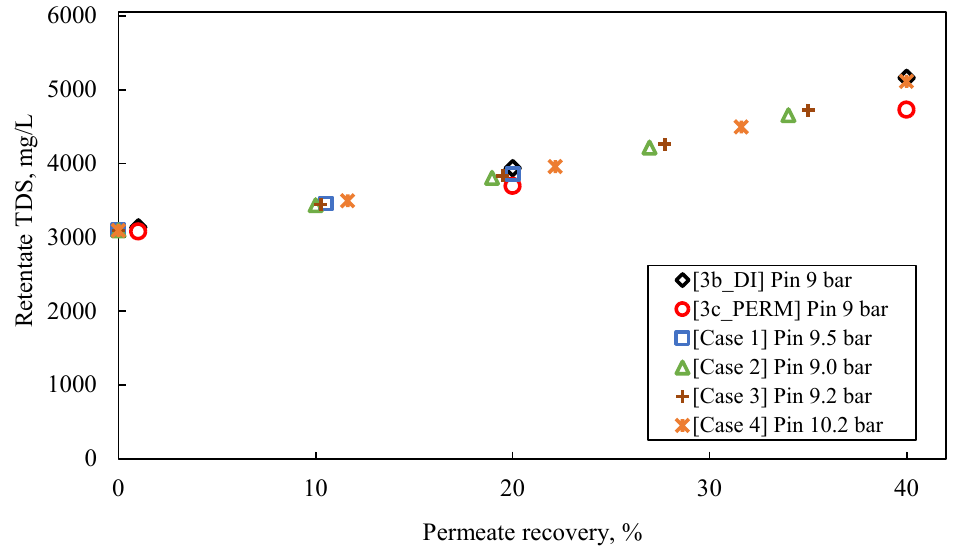
Figure 10. Experimental data (tests #3b_DI and #3c_PERM) on variation of retentate quality in terms of TDS, compared with results obtained from SWM simulator (Cases No 1–4); Feed: S5.